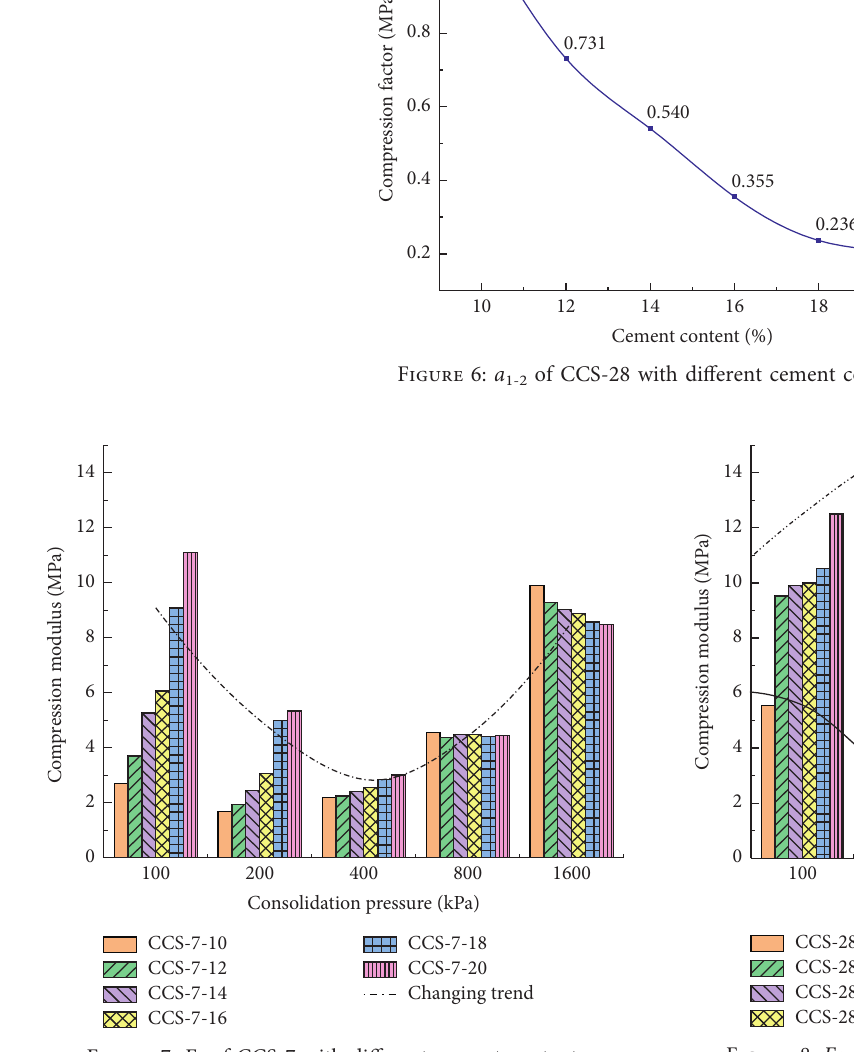
Figure 7: Es of CCS-7 with different cement content. Figure 8: Es of CCS-28 with different cement